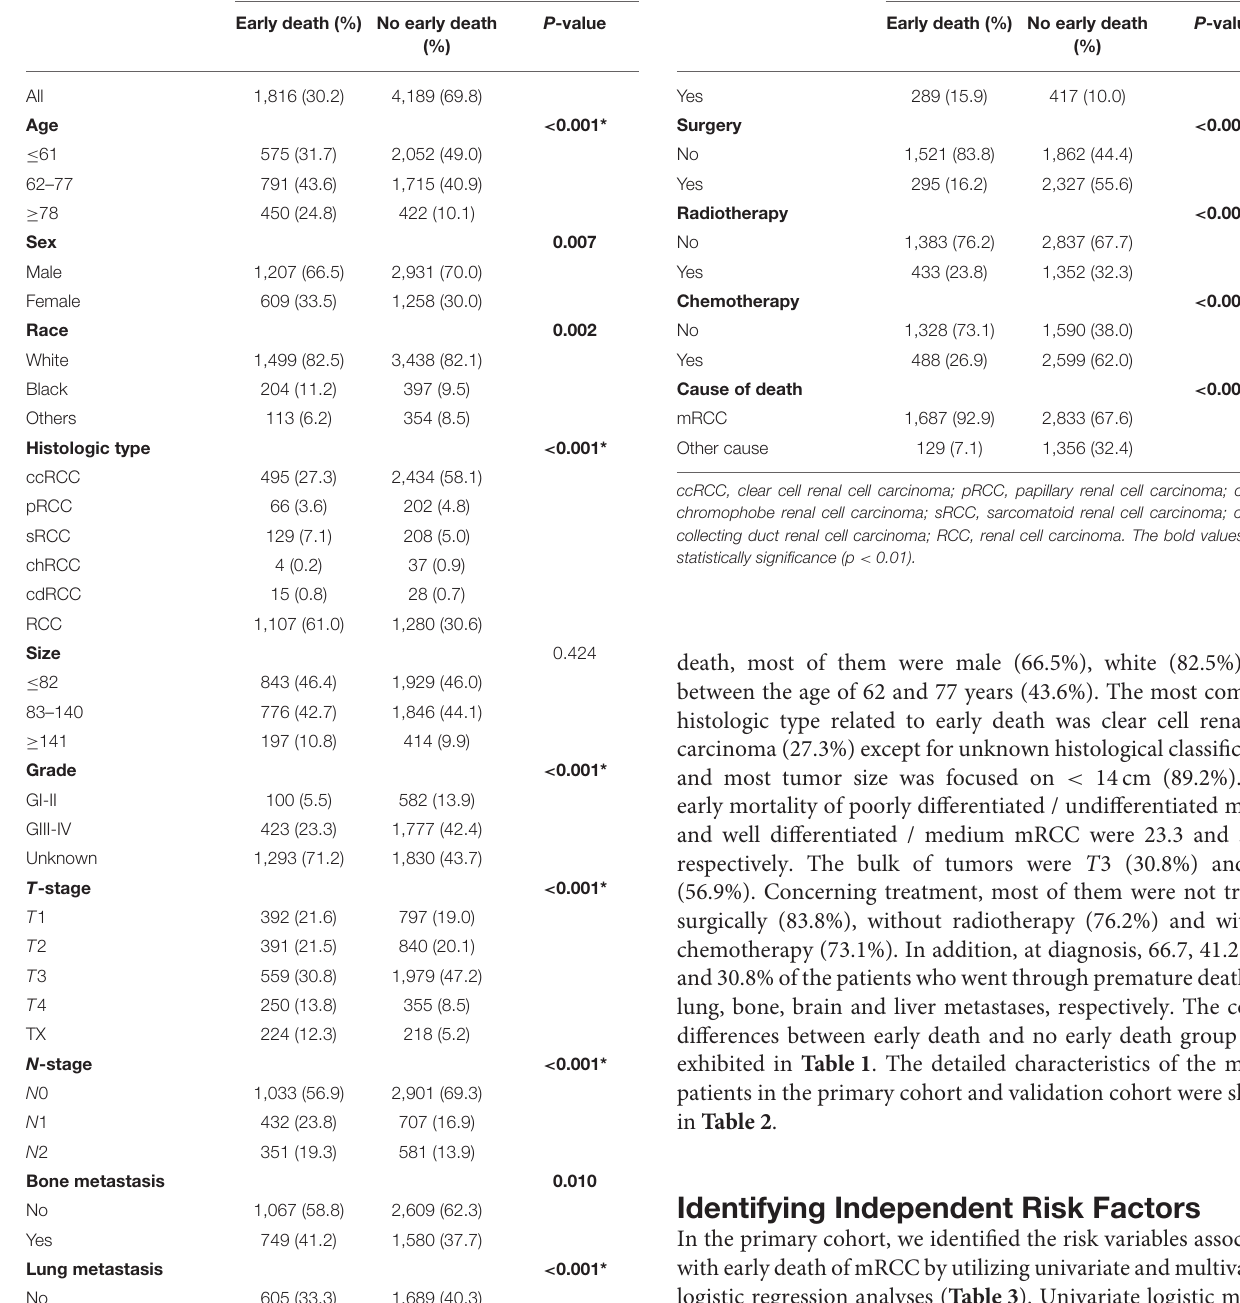
TABLE 1 | Early death or without early death events in patients with mRCC.